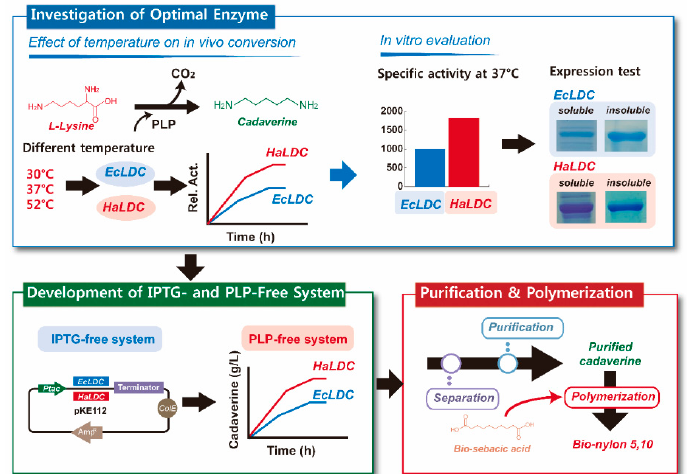
Figure 1. Schematic diagram for proposed production of bio-nylon 510 using purified cadaverine obtained from the pyridoxal pyrophosphate (PLP)- and isopropyl β - D -1-thiogalactopyranoside (IPTG)-free whole cell bioconversion of L -lysine, which is catalyzed by recombinant E. coli strains expressing a lysine decarboxylase from H. alvei and E. coli .